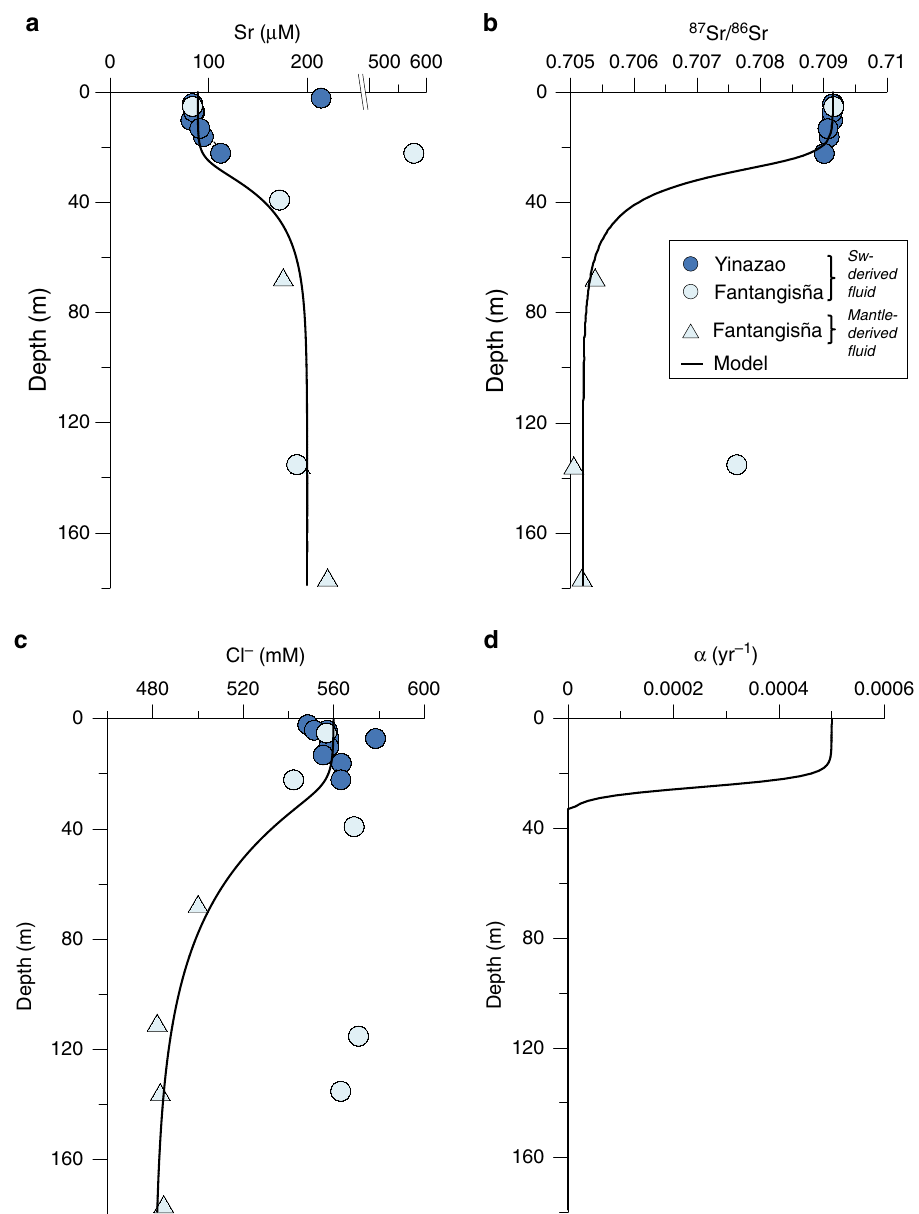
Fig. 4 Depth pro fi les of conservative tracers. a Dissolved Sr, ( b ) 87 Sr/ 86 Sr ratios in pore fl uids, ( c ) Dissolved Cl − (taken from Fryer et al. 28 ), ( d ) The non- local mixing coef fi cient α was derived by fi tting the model to the data ( a – c ). Dissolved Cl − , Sr, and 87 Sr/ 86 Sr ratio in the pore fl uid samples were employed to constrain the steady-state mixing rate and fl uid fl ow velocity assuming that the depth-distribution of these dissolved tracers is governed by transport processes rather than precipitation/dissolution reactions. The best fi t to these data was obtained applying mixing in the upper 30 m with a non-locale mixing coef fi cient of 5 × 10 − 4 yr − 1 and an upward fl uid fl ow velocity of 0.01 cm yr − 1 . Thick lines indicate steady-state model results (Supplementary circle in Fig. 1b; Fig. 6a, b). The δ 30 Si and δ 11 B values increase in undersaturated due to the entrainment of almost pH-neutral seawater (Fig. 5). The persistent mixing in the surface layer with seawater the about upper 30 m of the seamounts even though isotopically supports high dissolution rates (~1.2 µmol cm − 3 yr − 1 ) whereas the depleted Si ( δ 30 Si = − 0.3 ‰ ; Supplementary Table 2) and B ( δ 11 B = + 16 ‰ ; see section “ Drivers of deep mantle-derived δ 30 Si and rates are low in the deeper layers (<10 − 5 µmol cm − 3 yr − 1 ) that are δ 11 B values ” ) are released by the dissolving serpentine. This not affected by mixing with ambient seawater (Fig. 5). Serpentine, which formed in the mantle wedge, becomes unstable after observation can only be explained by formation of authigenic deposition on the sea fl oor either as serpentinized clasts or as minerals removing isotopically depleted Si and B from the pore fl uids (Figs. 2, 6). The formation of authigenic minerals was simulated by allowing talc (Mg 3 Si 4 O 10 (OH) 2 ) precipitation in the model. Talc was chosen because thermodynamic equilibrium calculations conducted with PHREEQC 35 show that the surface layer of the seamounts is strongly oversaturated with respect to thereby releasing Si and B into the pore fl uid (see also upper red